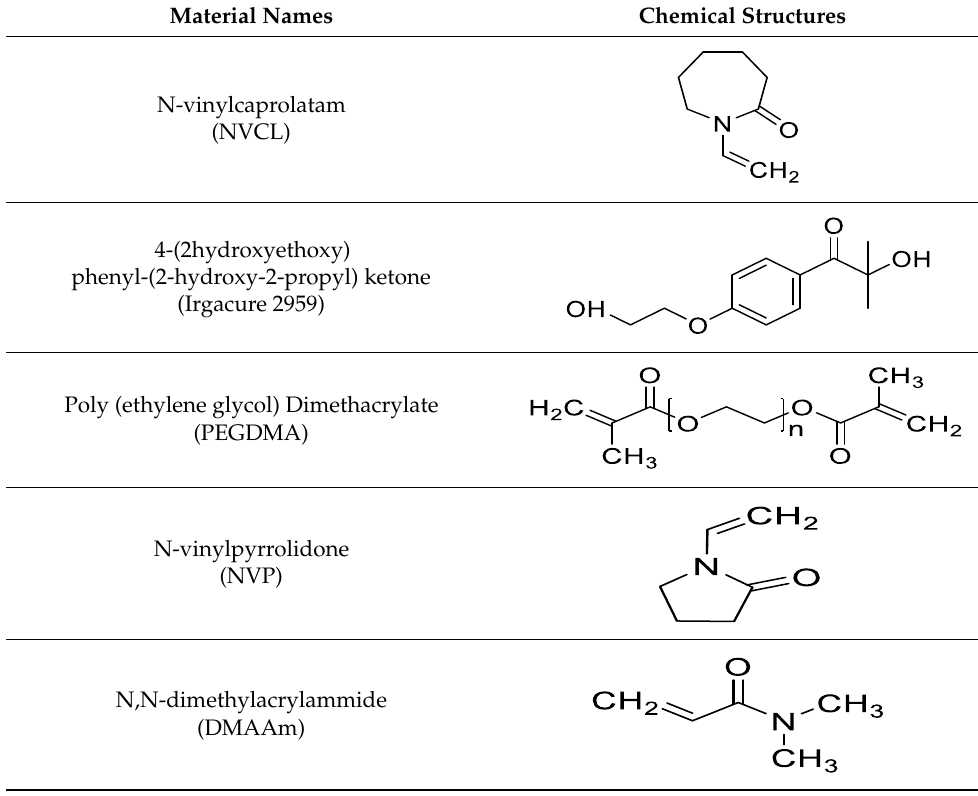
Table 1. Name and chemical structure of the selected